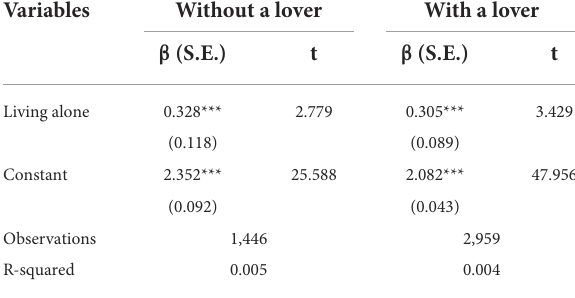
TABLE 6 Effect of the live alone on mental health, by with a lover